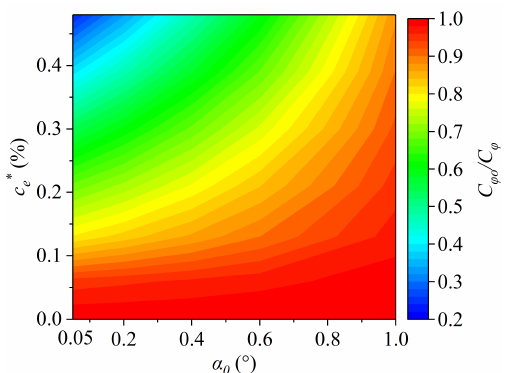
Figure 10. The flow rate coefficients of the flow through the narrow gap between two guide vane blades vs. the guide vane opening and end wall clearance width.